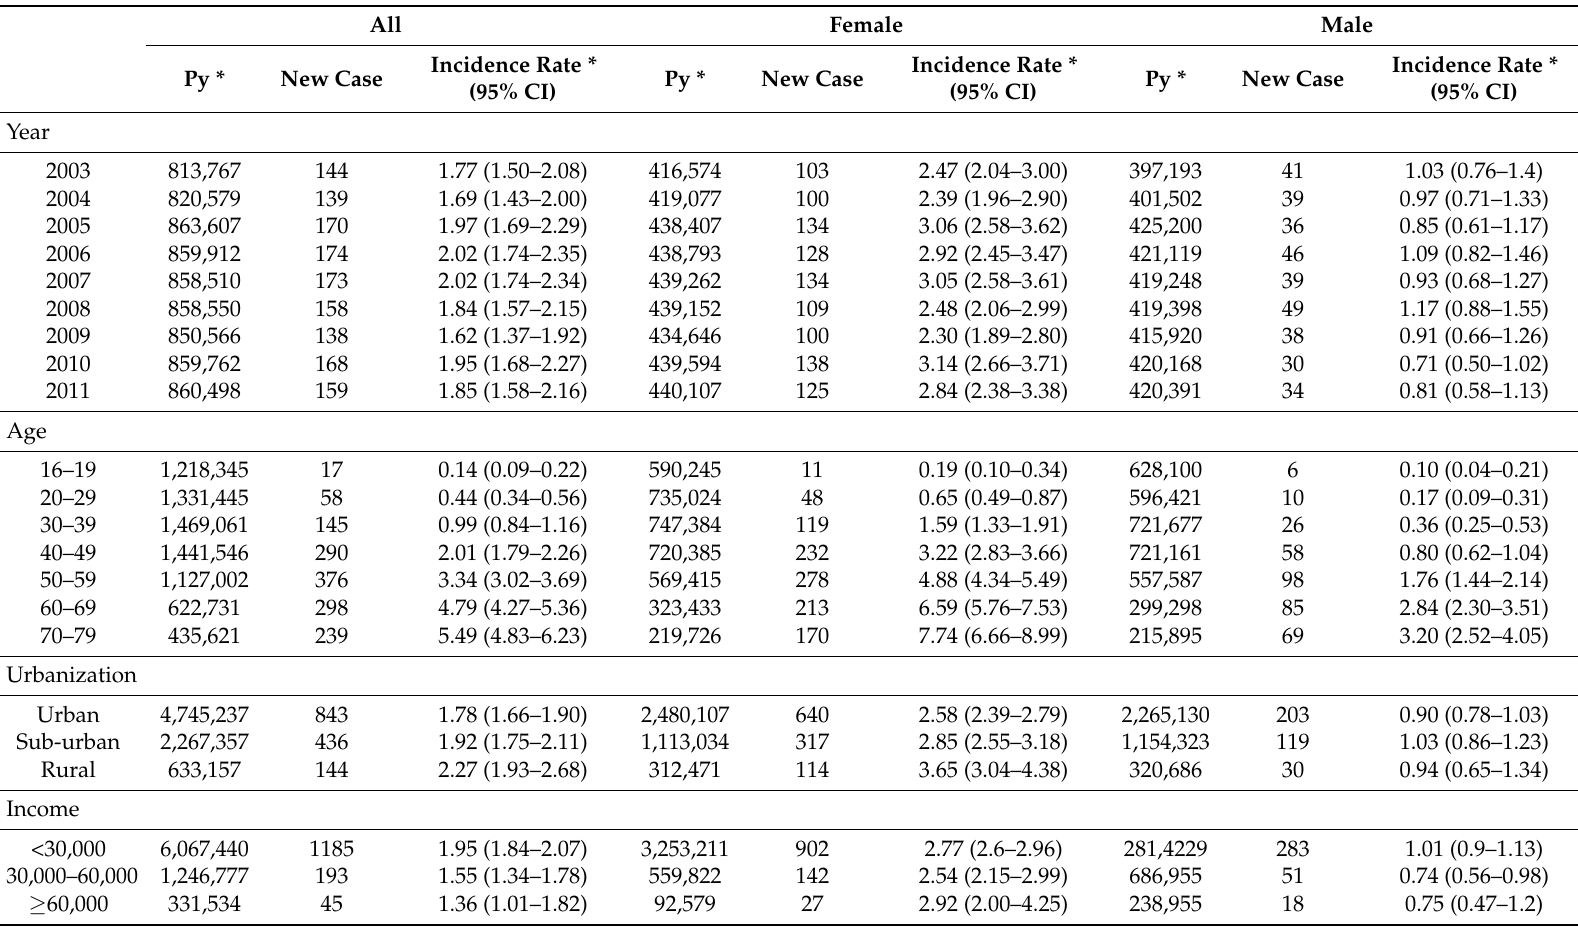
Table 3. Incidence rate (per 10,000 person years) of Rheumatoid Arthritis among 16–79-year-old people in Taiwan from 2003 to 2011 by specific